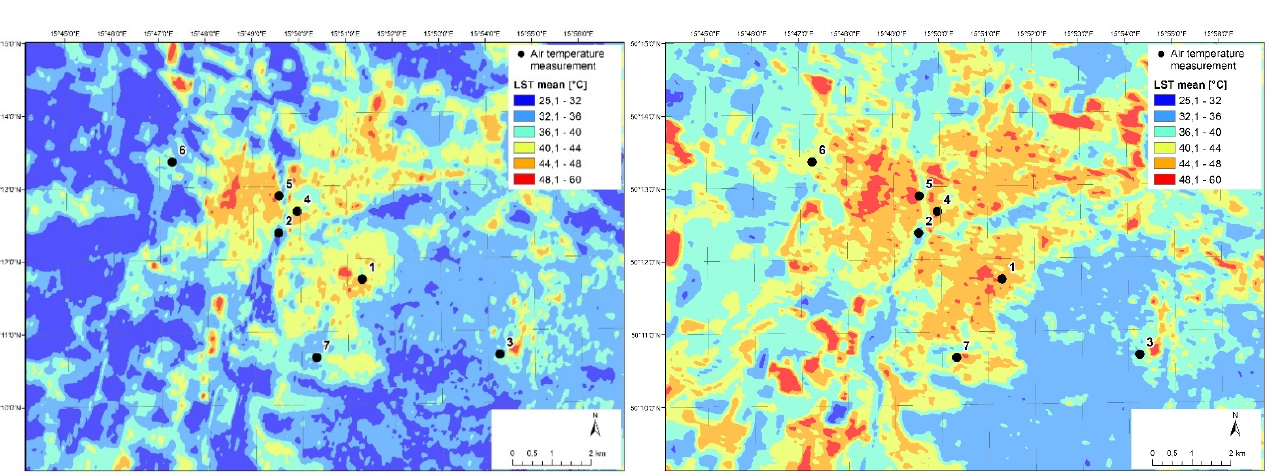
Figure 5. Land surface temperature in Hradec Králové and its surroundings, black dots (1–7) represent individual AT measurement sites; scene LC81900252013169LGN01 (left) and scene LC81910252013208LGN01 (right).